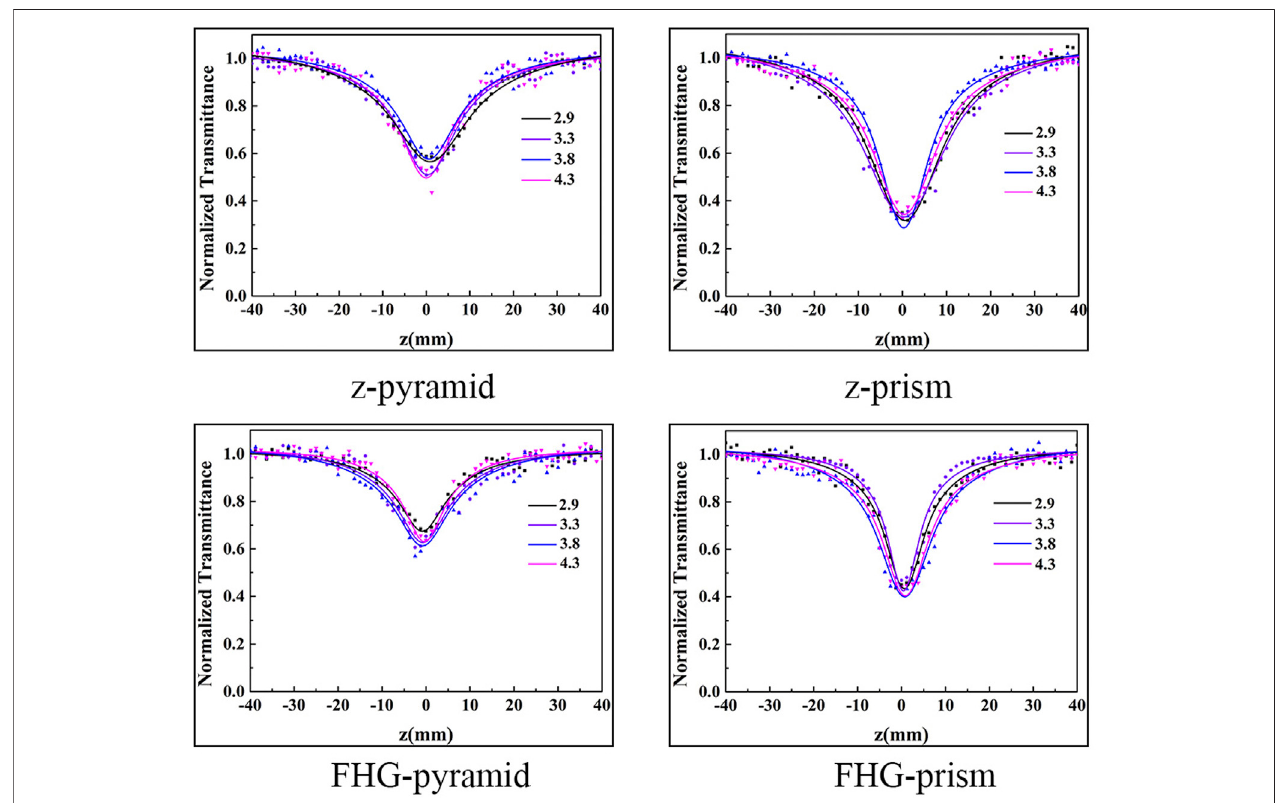
FIGURE 8 | The NLA curves of samples with an I 0 of 32 GW/cm 2